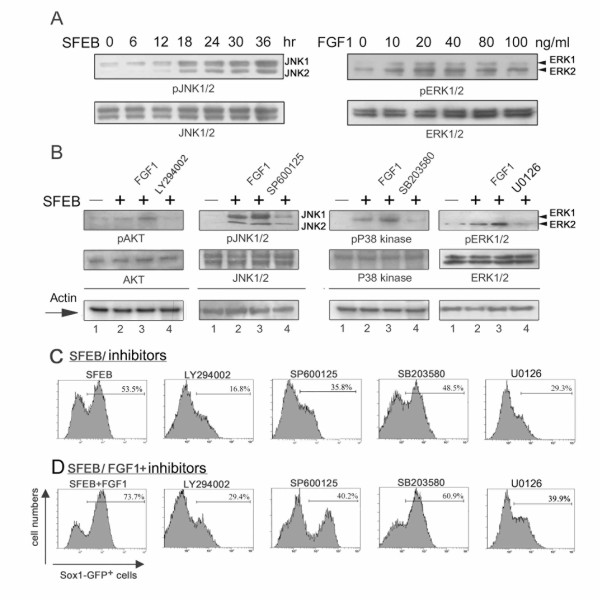
Effects of MAPK inhibitors on neural induction of ES cells. (A) Total cell lysates were collected from differentiating ES cells at indicated times under SFEB condition. Kinetic JNKs activation was analyzed by western blot. FGF1 dose-effect on differentiating ES cells was revealed by ERK phosphorylation at 30 min differentiation. (B) Downstream FGF signals were further detected with individual specific antibodies at 12 hr post-treatment of 40 ng/ml FGF1 (lane 3), or with inhibitors (lane 4) of PI3K/AKT (LY 294002, 10 μM), JNK1/2 (SP 600125, 10 μM), p38 MAPK (SB 203580, 20 μM), and ERK1/2 (U0126, 5 μM). After treatment with the inhibitors (C) or FGF1 (40 ng/ml) plus the inhibitors (D) from day 1 to day 3, the derived cells were collected for FACS analysis on day 6. The same concentrations of reagents were applied in these experiments. Representative results were shown from experiments done at least in triplicate.